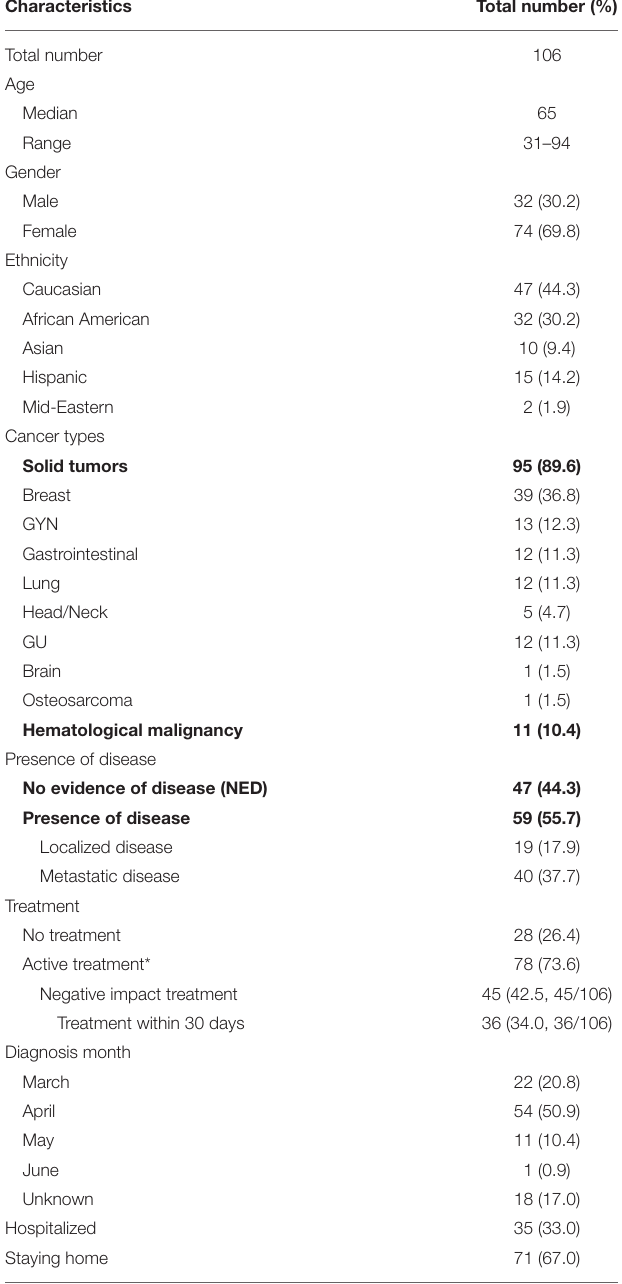
TABLE 1 | Patient demographics and disease characteristics.